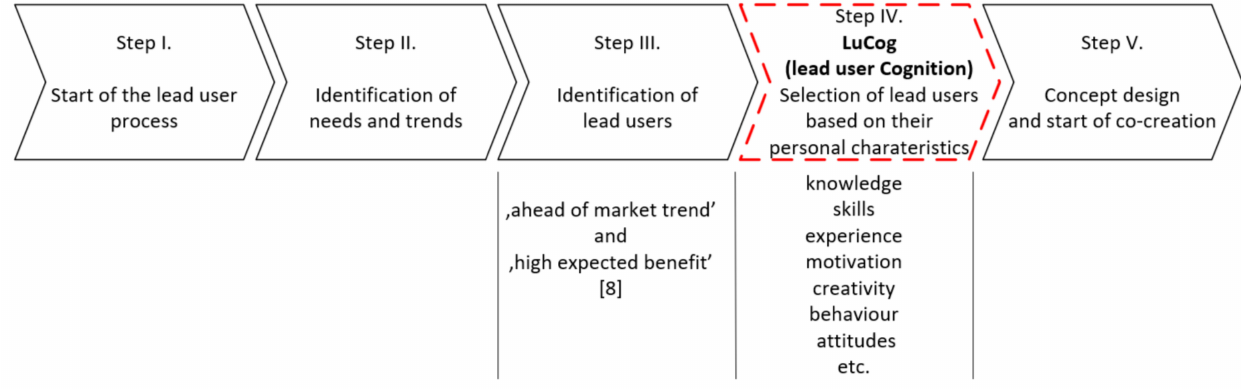
Figure 5. The extended lead-user